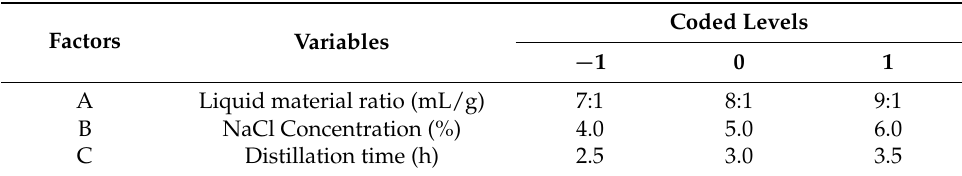
Table 4. Variables and levels of response surface